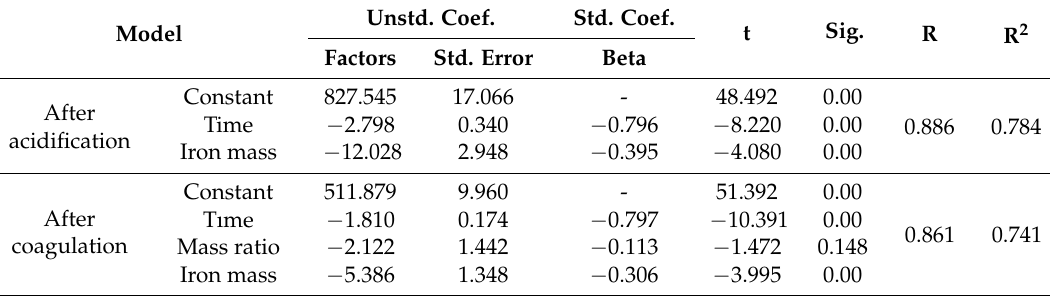
Table 4. Regression coefficients for the Fe 0 /H 2 O 2 process. Dependent variable: TOC. Model